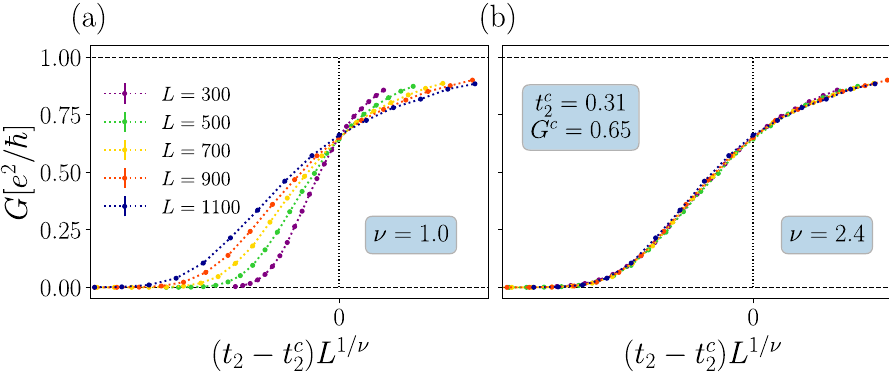
Fig. 5 Finite-size scaling of conductance for half- fi lled systems. a Conductance data fi t at the mass parameter M = 0.8 with the 2d class D exponent ν = 1, which fails to capture the correct scaling behaviour. In contrast, with the localization exponent ν = 2.4 in b the data collapse to a universal curve. Curves are averaged over 10 3 − 10 4 distinct random fractal con fi gurations at each data